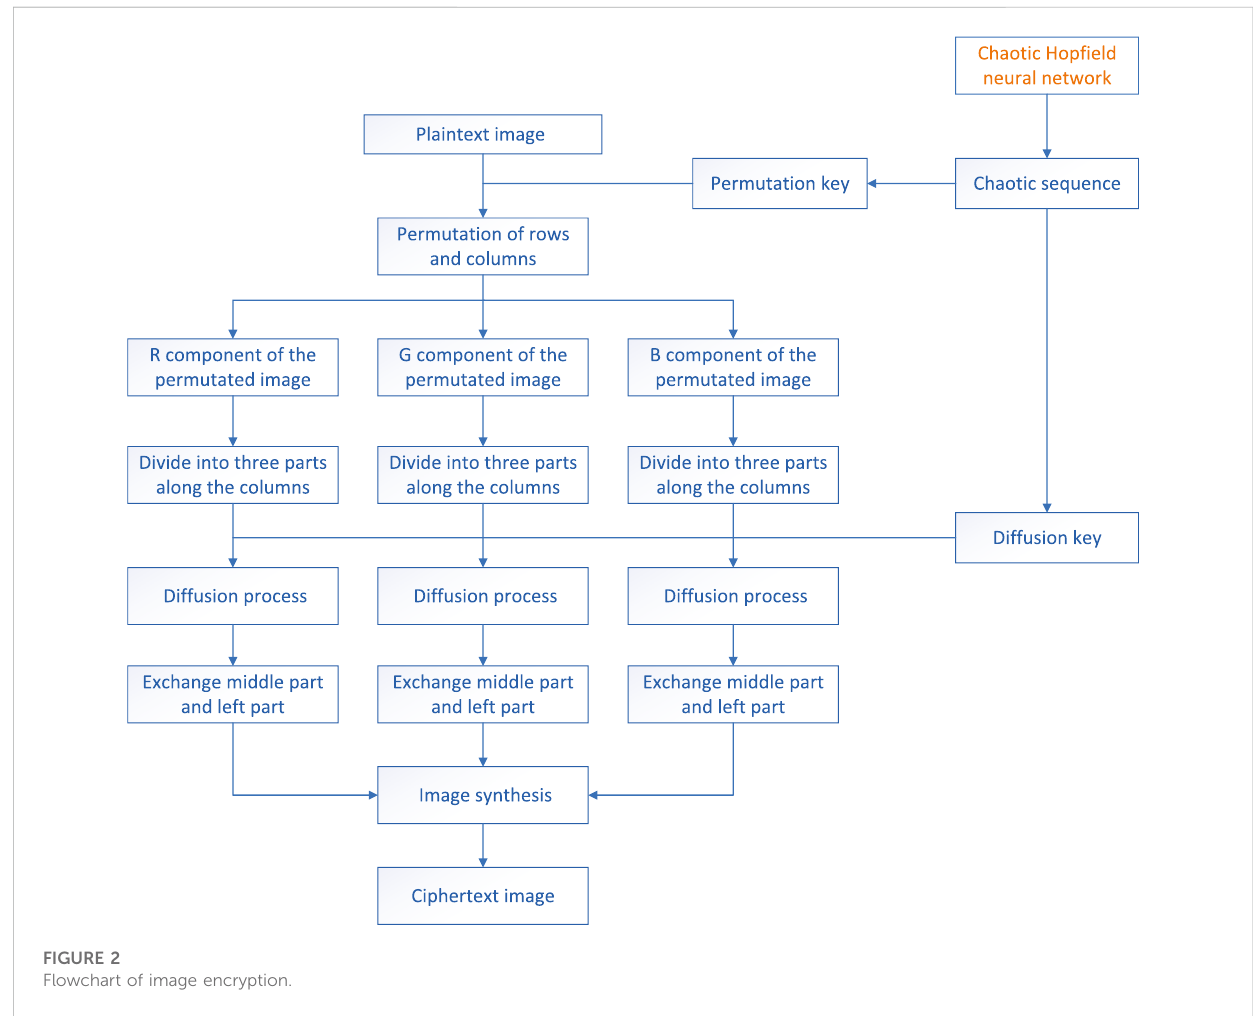
FIGURE 2 Flowchart of image